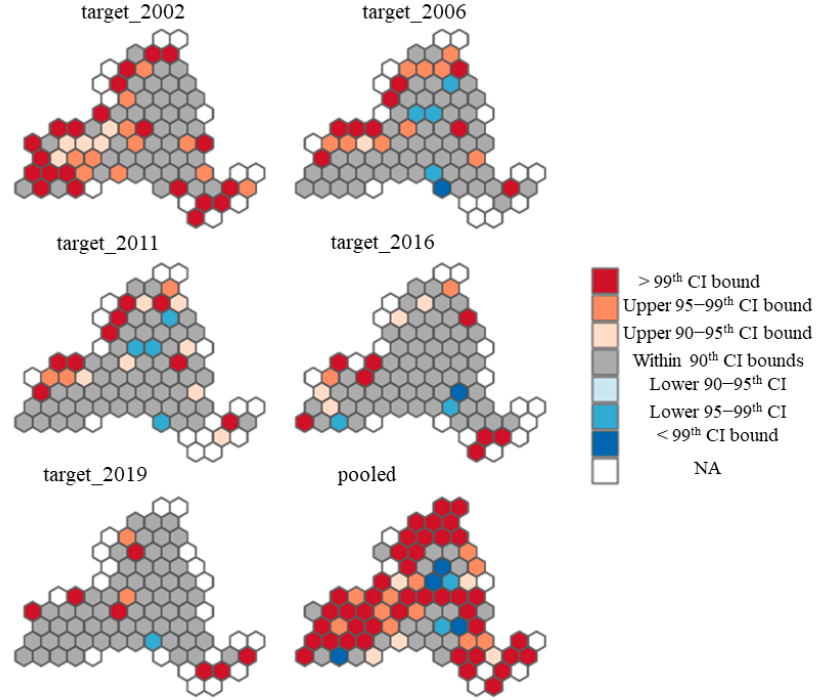
Figure 12. Mapped differences in modeled area estimates at the 216,500 ha scale with respect to plot-based confidence intervals (2002, 2006, 2011, 2016, 2019, and pooled).